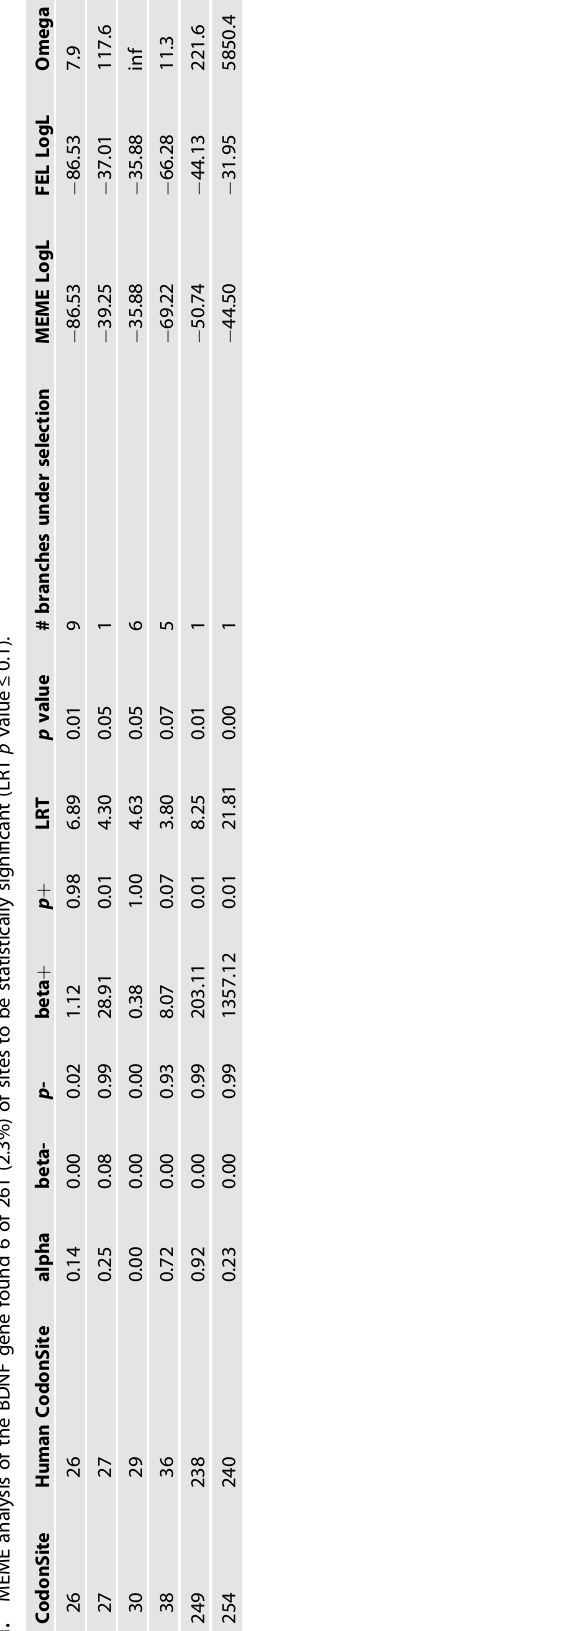
Table 1) in regions of BDNF that may provide signi fi cant areas of interest for designing molecular therapeutic approaches, and their potential broader signi fi cance are outlined in further detail below. Predominant purifying selection across BDNF in Mammalia Over time, evolution drives the divergence of genetic sequences, but what can we learn from the direct comparison of the sequences of the BDNF gene in Mammalia ? By comparing the BDNF products of orthologous sequences in different species, we observe the accumulation of mutations at different sites with varying degrees of insight into both BDNF functionality (see [29] for site annotation) and potential disease [1]. These are summarized in full within Table S1 and Table 1. Coding sequences with highly constrained structures are expected to fi x nonsynon- ymous mutations at a slower rate due to the maladaptive nature of changes such as what we observe with FEL negatively selected sites across BDNF. Additionally, we observe a high degree of negative (purifying) selection across the main functional domain (NGF) of BDNF. While structures for the NGF domain in most species under analysis do not exist, based on our fi ndings we T a